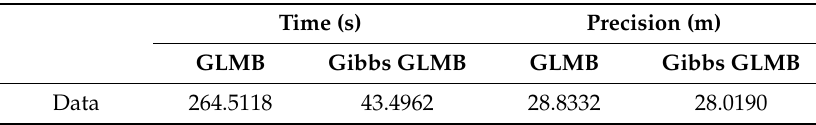
Table 3. The running time and precision of filters (the average of 10